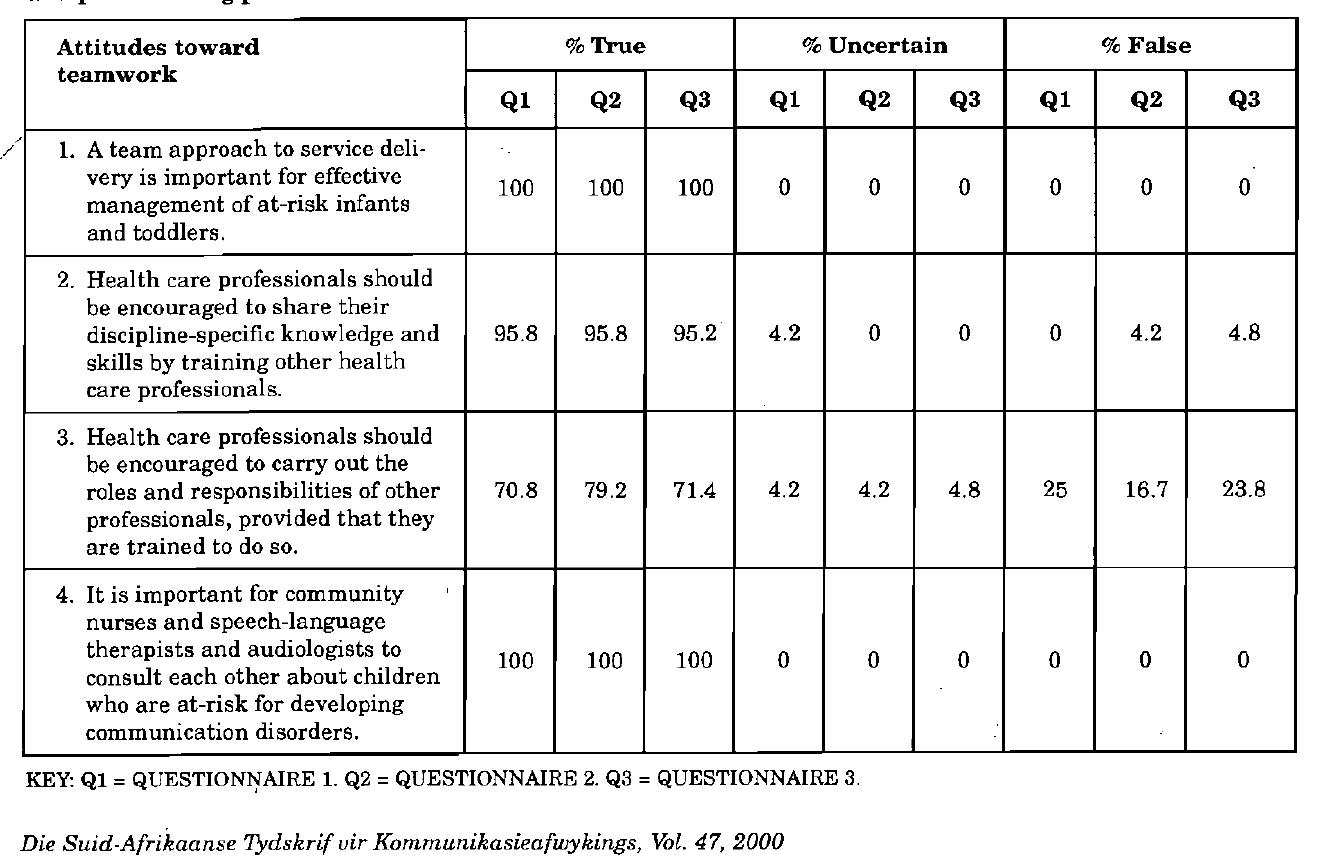
TABLE 5: Community nurses' attitudes regarding teamwork in early intervention as evident during the pre- and post-training